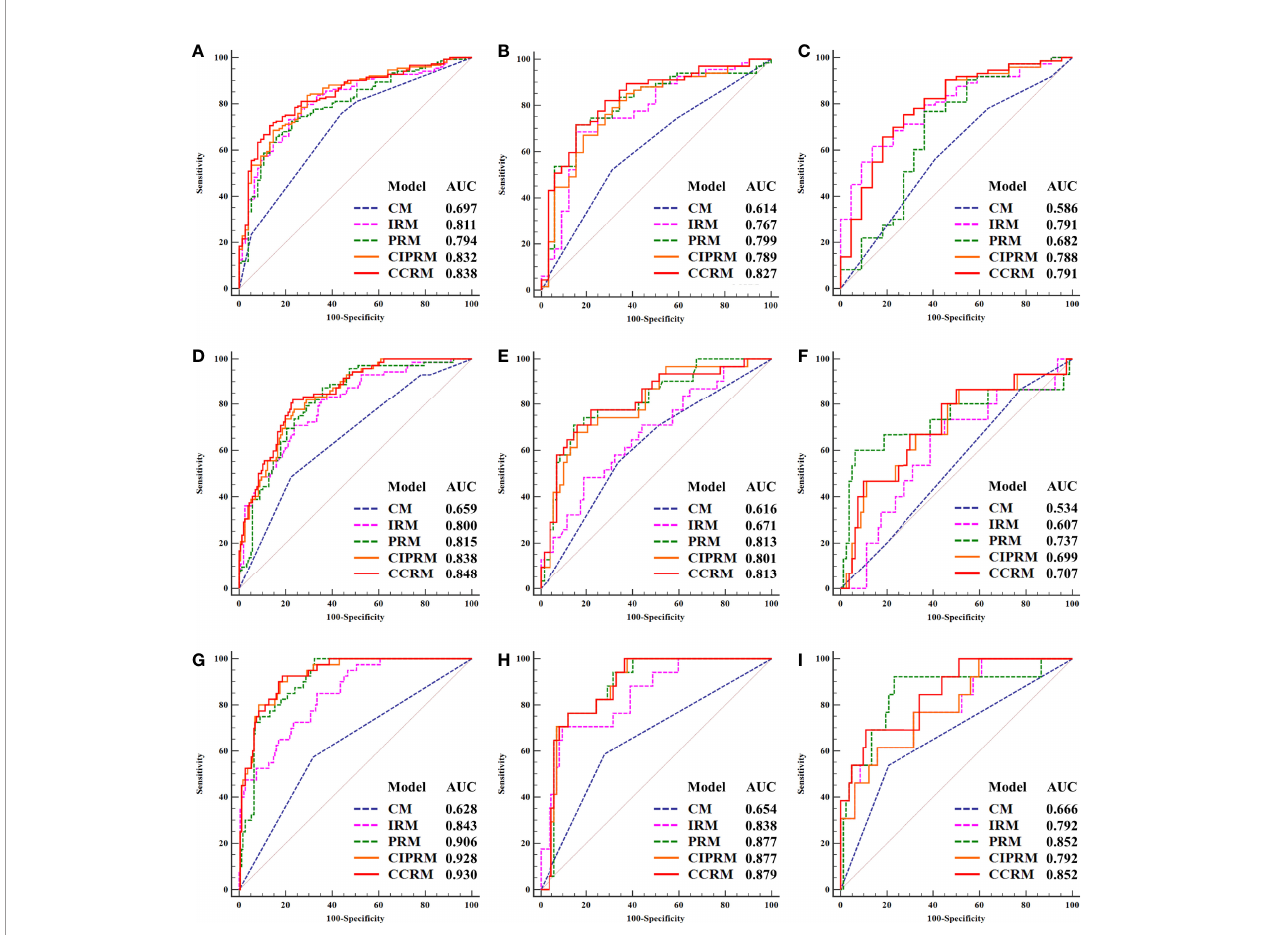
FIGURE 4 | Receiver operating characteristic (ROC) curves of fi ve models in the training, internal, and external test cohorts of task 1 (HR-positive vs HR-negative, (A) training cohort, (B) internal test cohort, (C) external test cohort), task 2 (HER2-enriched vs non-HER2-enriched, (D) training cohort, (E) internal test cohort, (F) external test cohort), and task 3 (TNBC vs non-TNBC, (G) training cohort, (H) internal test cohort, (I) external test